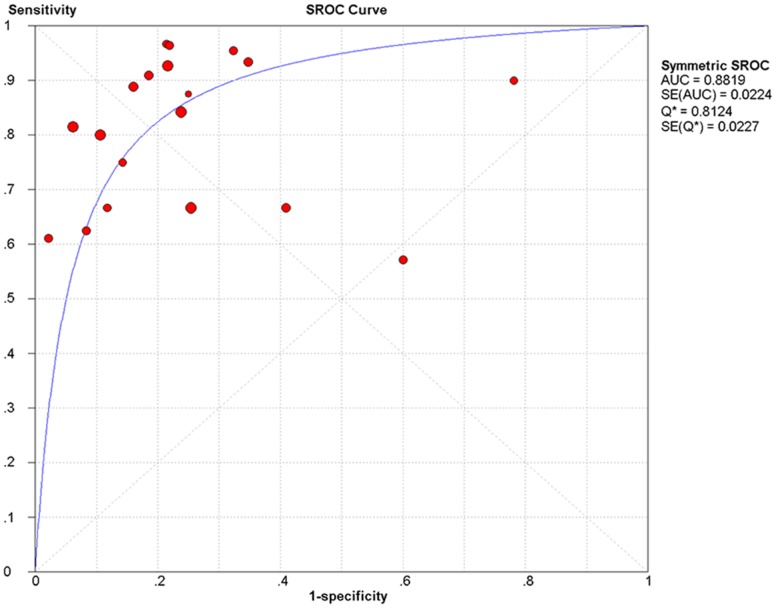
Summary receiver operating characteristic (SROC) curve for anti-granulocyte scintigraphy with 99mTc-monoclonal antibodies in the diagnosis of periprosthetic joint infections (PJI) in the 19 included studies.Solid circles represent each study included in the meta-analysis. The size of each study is indicated by the size of the solid circle. The regression SROC curve summarizes the overall diagnostic accuracy. AUC (area under the curve)  =  0.88, Q*  =  0.81.